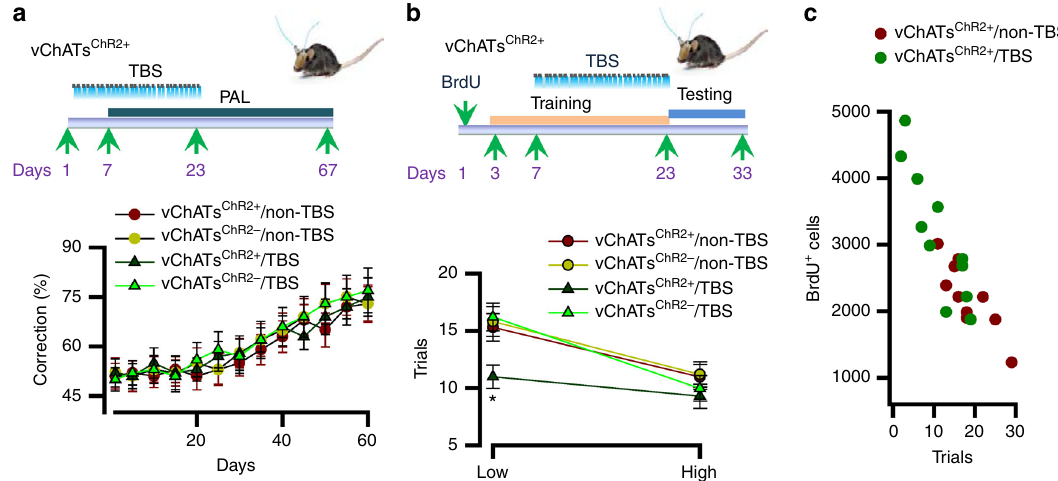
Fig. 4 Enhancement of spatial pattern separation increases the dNGIs survival. a The experimental schedules (top) show that mice at 120 ± 2 days old of age were applied with TBS. 7 days after the beginning of TBS, mice were performed with 16-days PAL. The percentage (bottom) of corrections in 60-days PAL is plotted (mean ± SEM, n = 11 mice/group). b The experimental schedules (top) show that mice (after the completion of PAL) were administered with a single dose of BrdU. 7 days after the administration, mice were trained with 2-CSD. 4 days after the beginning of the training, mice were treated with 16- days TBS. Following the completion of 20-days training, mice were applied for a 5-day block test on each separation (high or low). Immediately after end of the tests, mice were euthanized for BrdU staining. The numbers (bottom) of trials that are required to reach a criterion at a high or a low separation of 2- CSD are plotted (mean ± SEM, n = 11 mice/group, F 1.43 = 11.02, * p = 0.00082, two-way ANOVA). c The numbers of trials that are required to reach a criterion at a low separation in b are plotted against the number of BrdU + cells from the individual